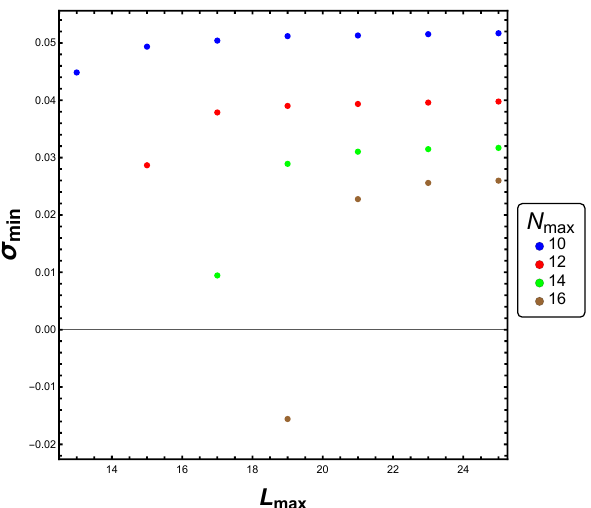
Figure 13: Variation of Average minimimum for s 0 = 0.3 and s 2 = 1.5 with N max